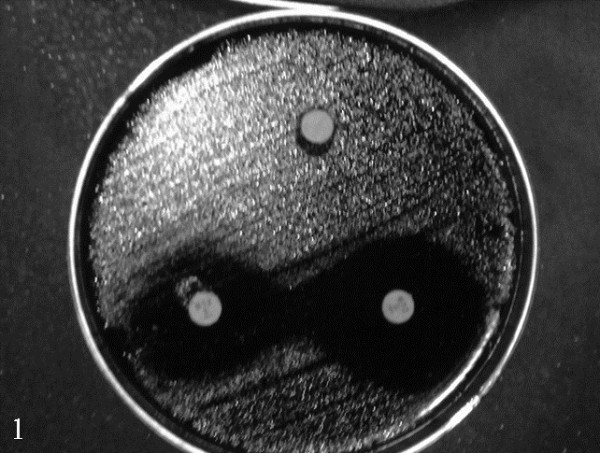
The combination of polysorbate 80 with metronidazole (disc on the right) increases the size of the growth inhibition halo; the disc on the left was charged with metronidazole alone and the disc at the top with polysorbate 80 alone.